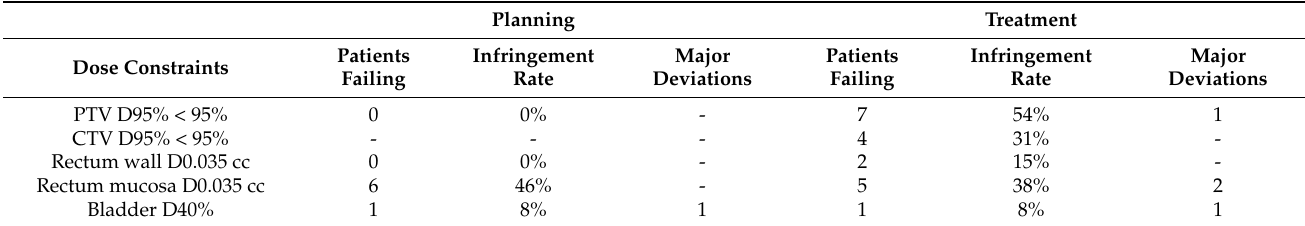
Table 4. Protocol dose constraint infringement rate for target and OARs, along with the number of patients who failed in planning and treatment, for the delivered